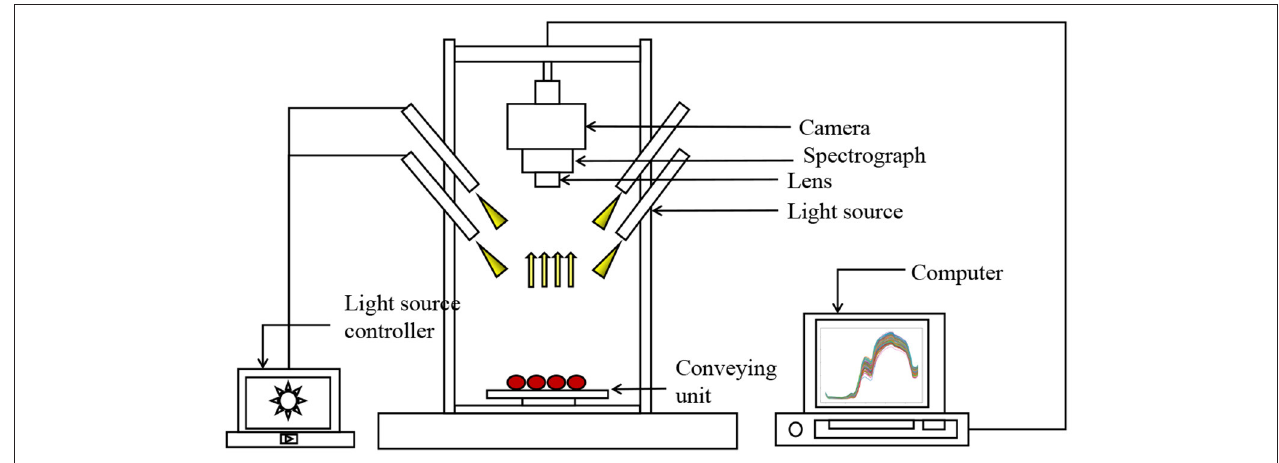
FIGURE 1 | Schematic of the hyperspectral imaging system for acquiring spectral scattering images from cherry tomatoes.